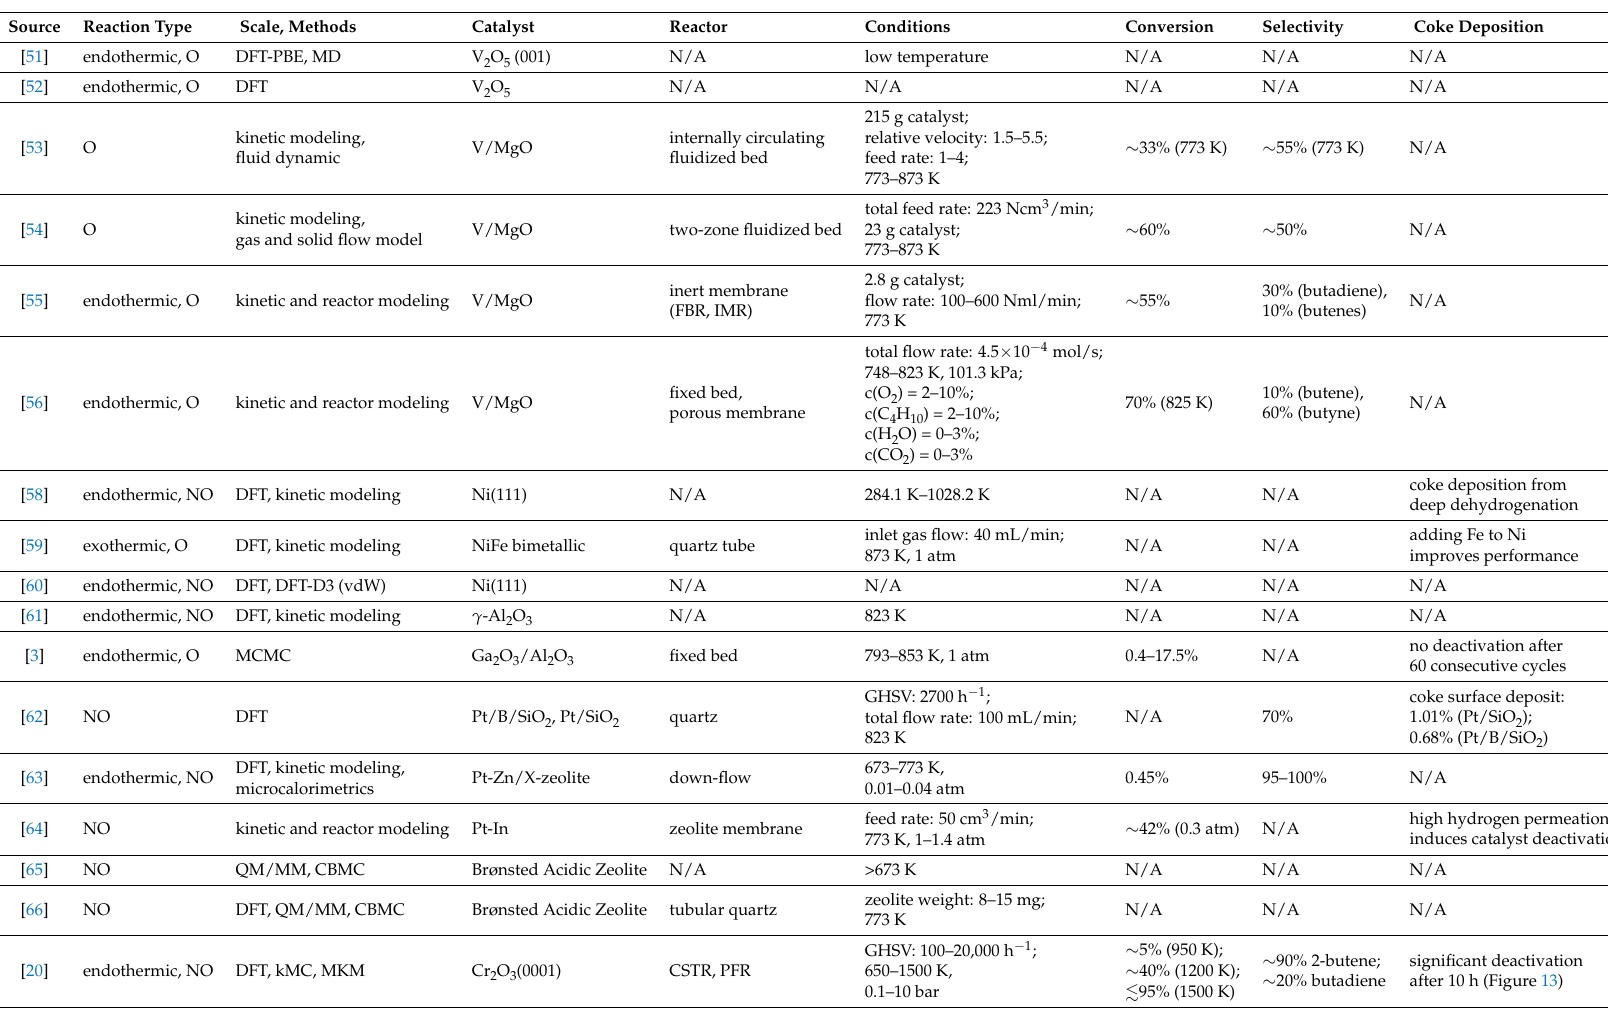
Table 3. The overview of the multiscale modeling results for butane dehydrogenation process over different catalysts, reactor types, and conditions. Oxidative (O) and non-oxidative (NO) reaction types were